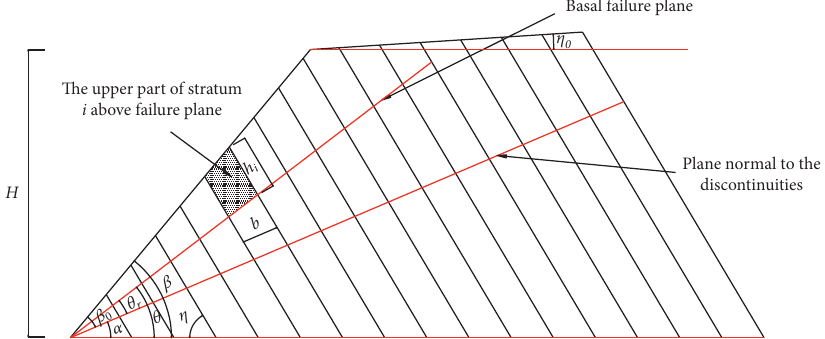
Figure 1: Geological geometrical model of an anaclinal layered slope.